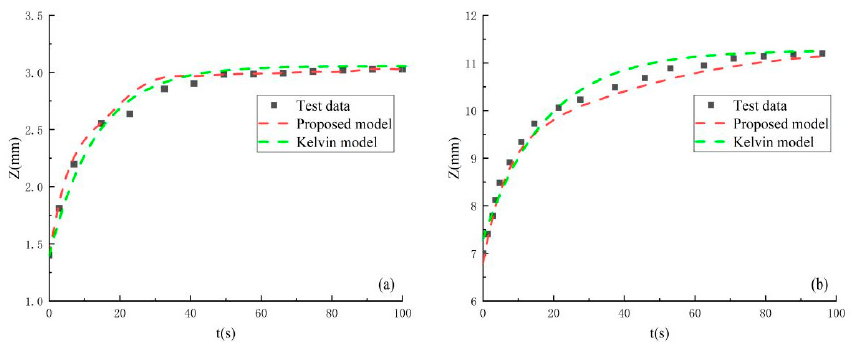
Figure 16. A comparison of the predictions of the as-proposed model with the experimental data and the Kelvin model: ( a ) P = 5 kPa; ( b ) P = 25